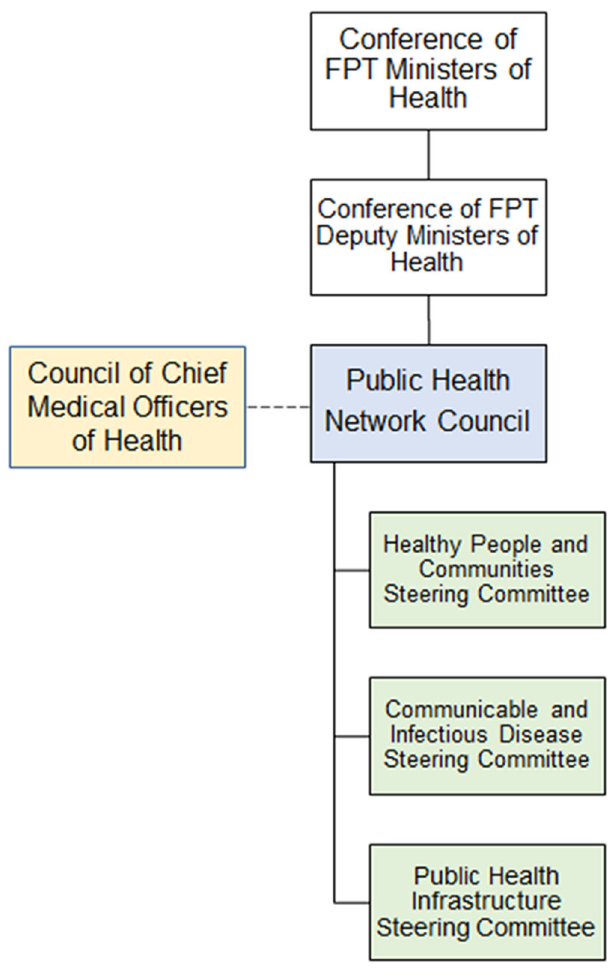
Fig. 2 Pan-Canadian Public Health Network (PHN) structure. The 17-